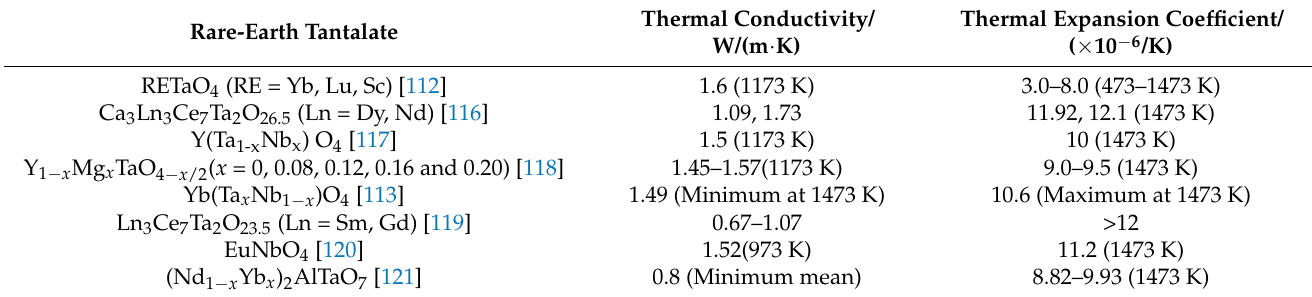
Table 1. Thermal physical properties of some rare-earth